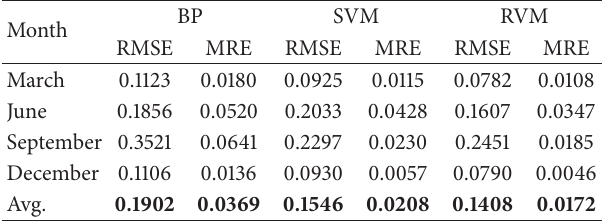
Table 1: Comparisons of forecast accuracy for three